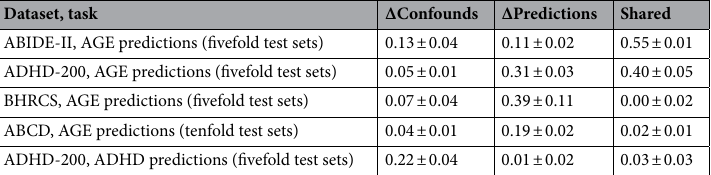
Table 4. Confounding effects for models’ predictions. Metrics are presented in mean values ± standard deviation. The numbers reflect the coefficient of determination of the target (R 2 cv for AGE and D 2 cv for ADHD). In column titles, ∆Confounds = confounds only, ∆Predictions = predictions only, and Shared = both confounds and predictions.